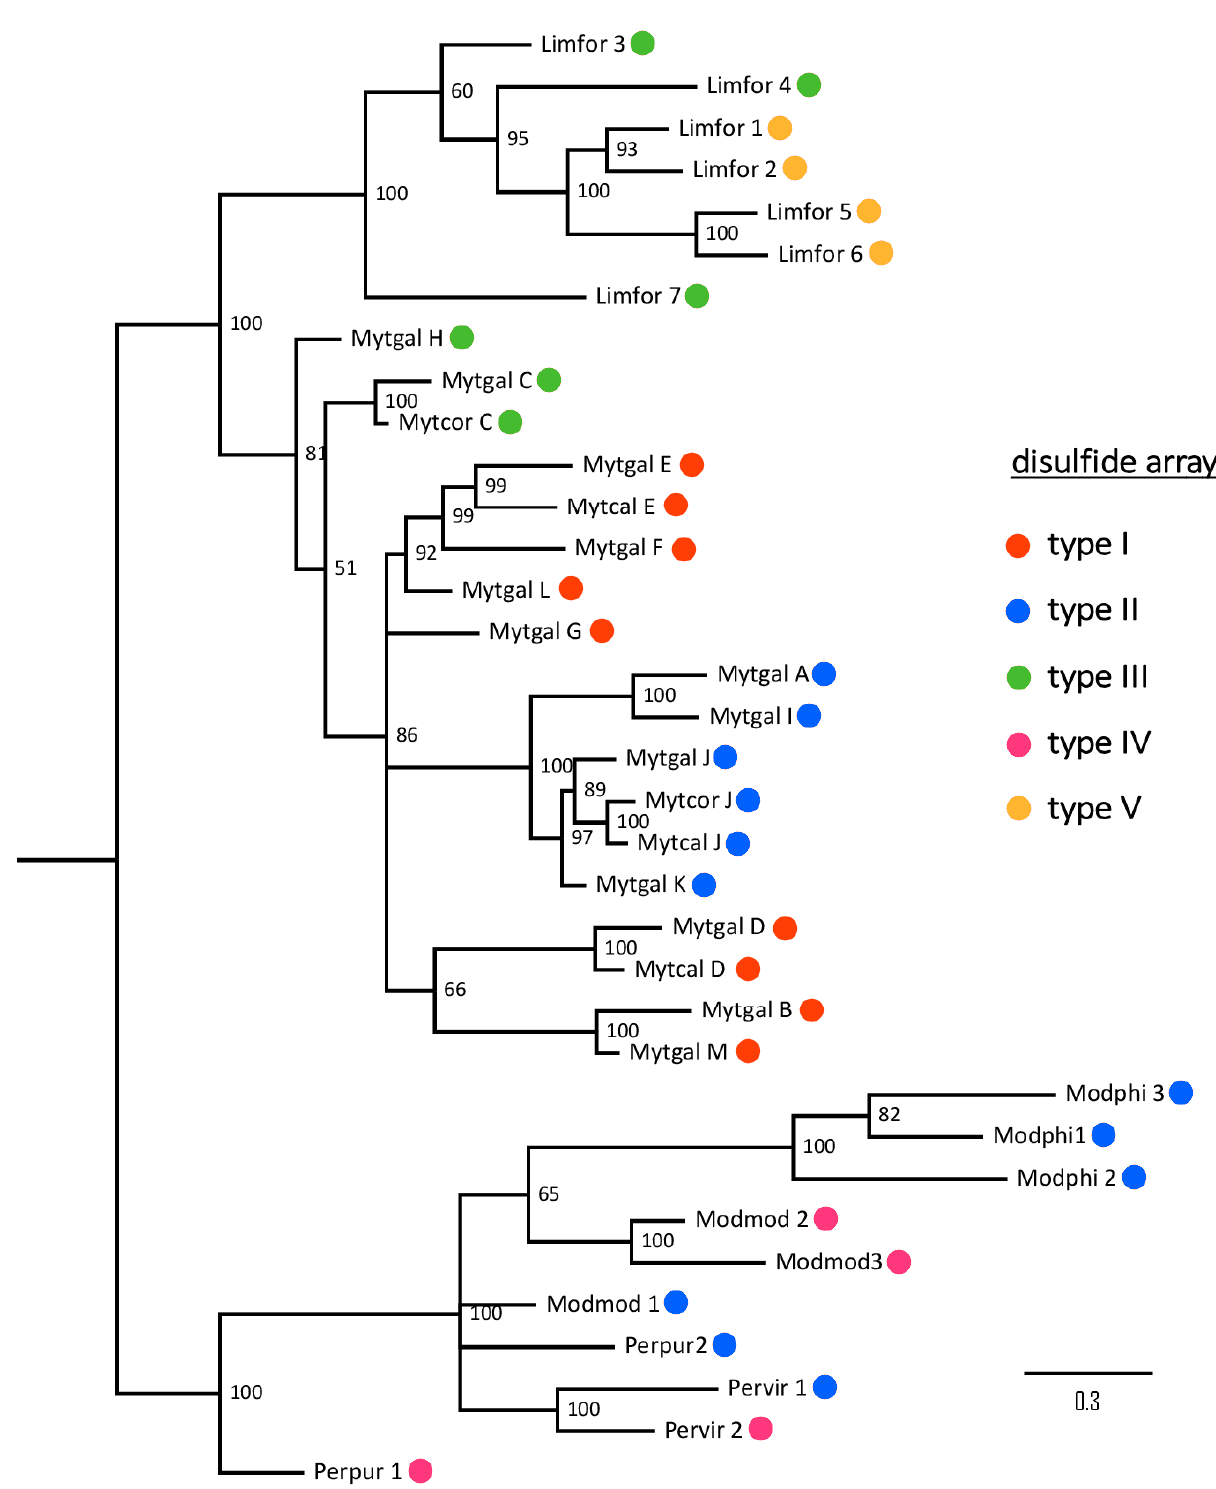
Figure 9. Bayesian phylogeny (run under a WAG+G model of molecular evolution, with a MCMC analysis with 500,000 generations) of the mytimycin sequences identified in different Mytilida species. Posterior probability support values are shown next to each node. Colored dots indicate the type of disulfide array observed in each sequence.